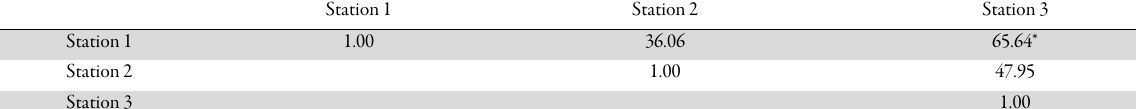
Table 5. Coincidence table showing Renkonen numbers calculated for pairs of sampling stations of River Idemili